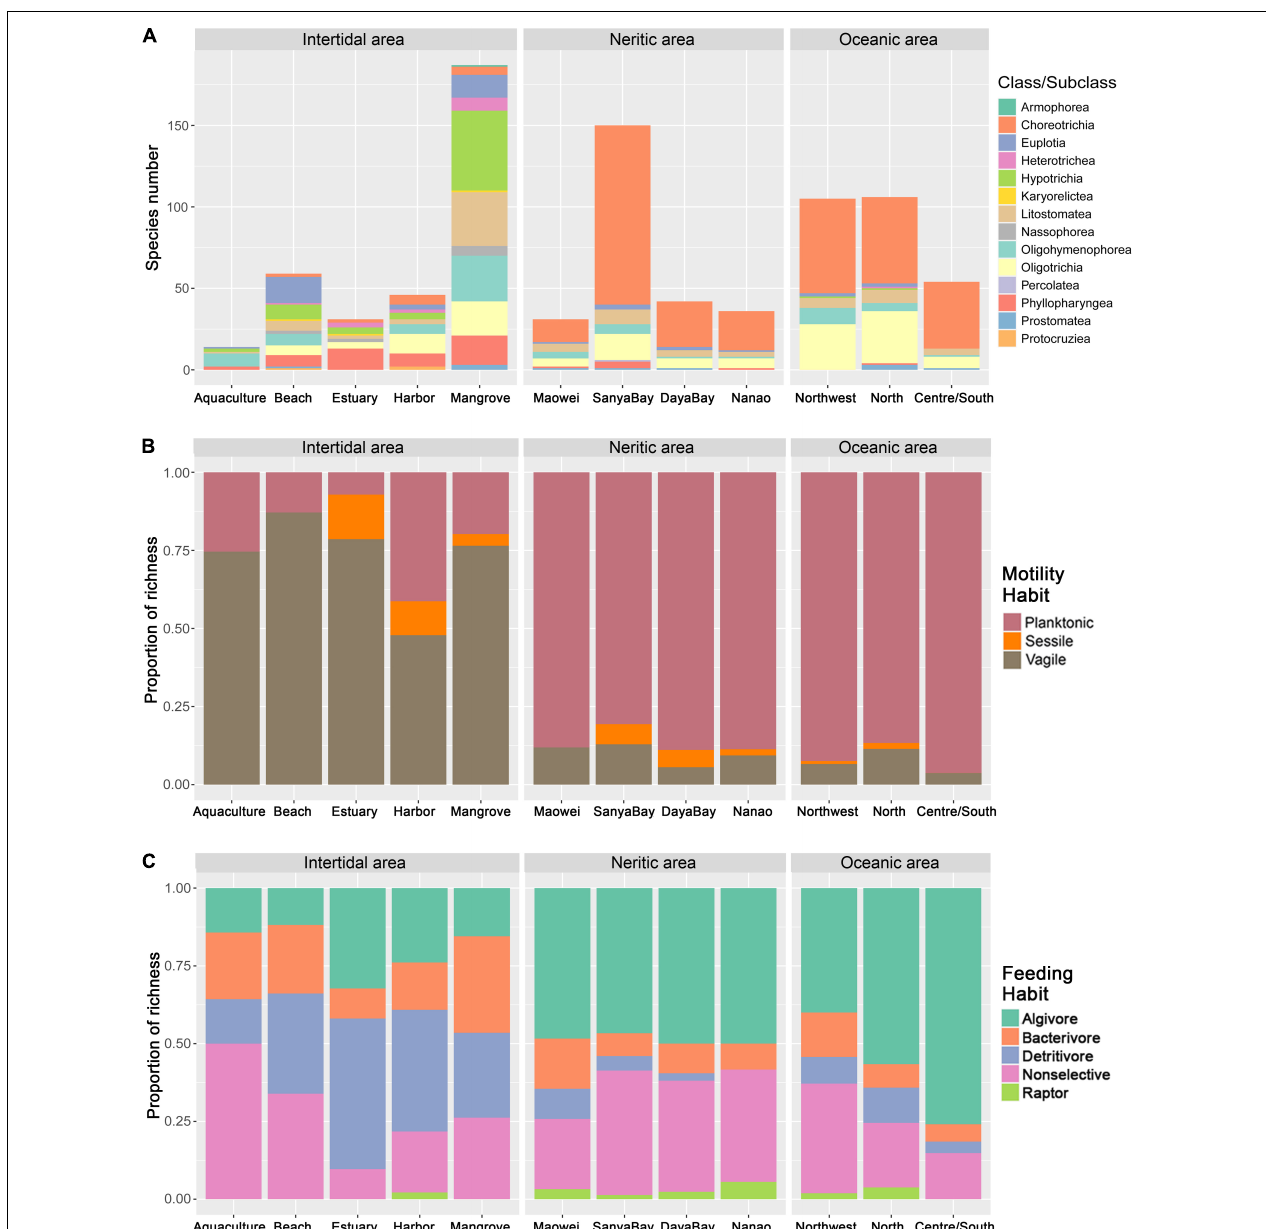
FIGURE 3 | Community variations of ciliate diversity among the subareas in SCS. (A) Comparison of ciliate species richness and composition at the class/subclass level among the subgroups. (B) Relative proportion of motility habit groupings among the subgroups. (C) Relative proportion of feeding habit groupings among the